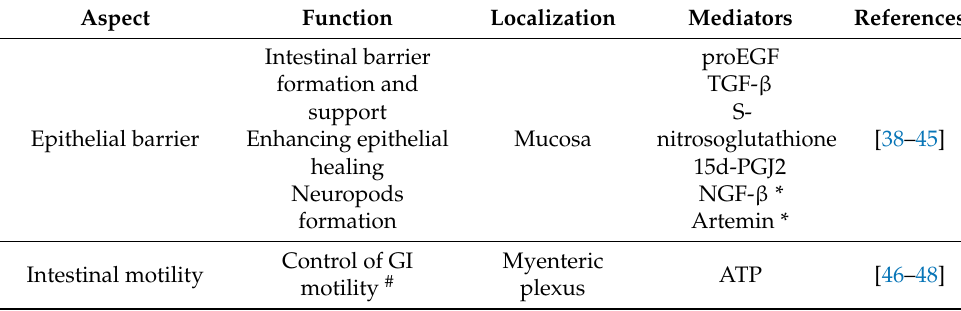
Table 1. Functions of the enteric glial cells in the gastrointestinal tract. Aspect